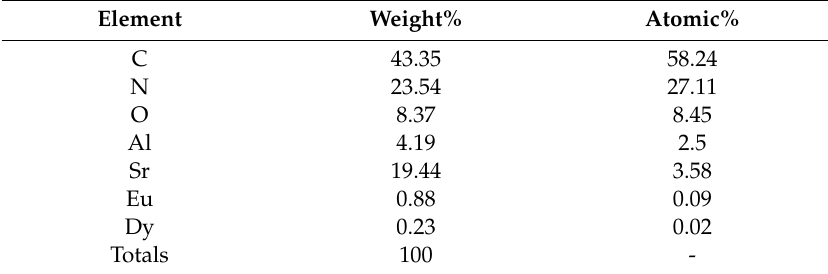
Totals 100 - Table 2. Elemental analysis for 50 wt.% g-C 3 N 4 supported on SrAl 2 O 4 :Eu,Dy-0.01M SiO 2. Element Weight%